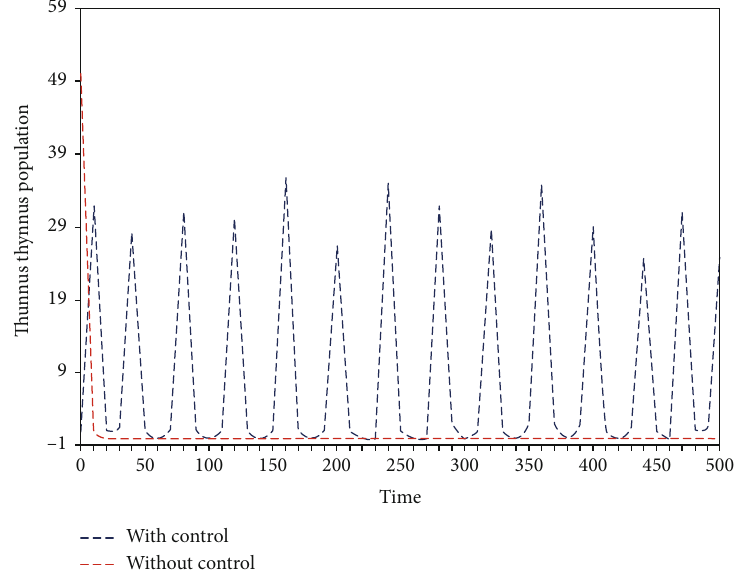
Figure 15: Thunnus thynnus population with optimal harvesting and e ff ort harvesting, with high e ff